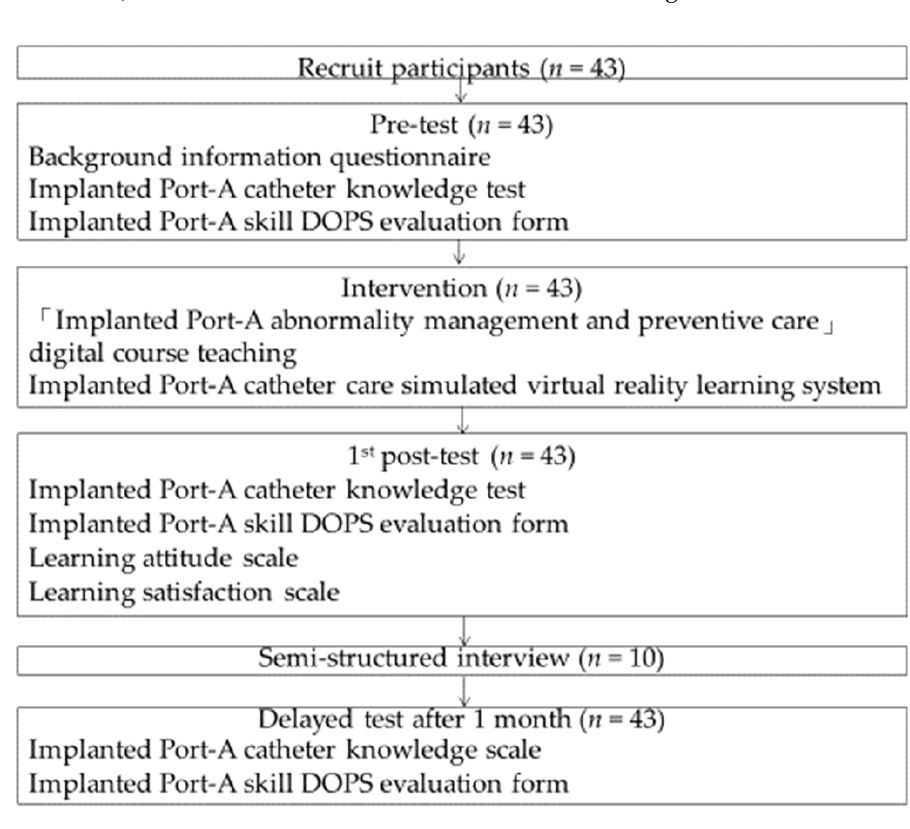
Figure 4. Procedure of the study.